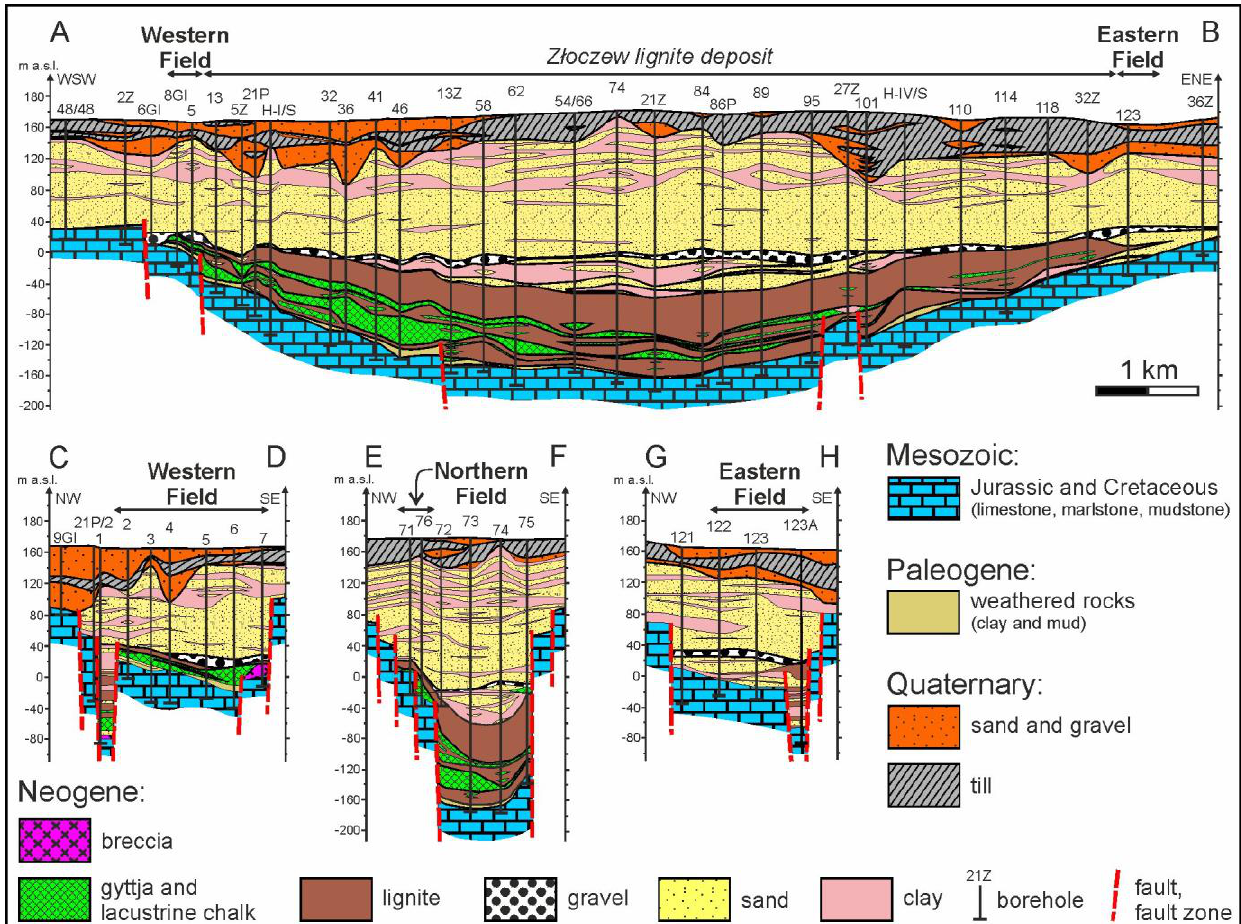
Figure 1. Geological cross sections through the Złoczew lignite deposit. Source: Based on [46].